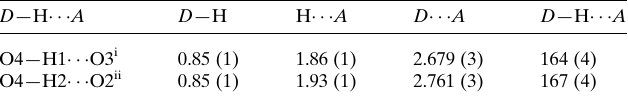
Table 2 Hydrogen-bond geometry (A˚ , (cid:4) ).